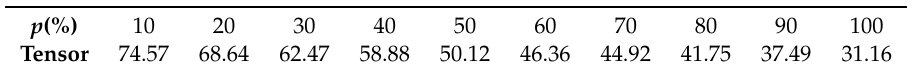
Table 13. Tensor density.